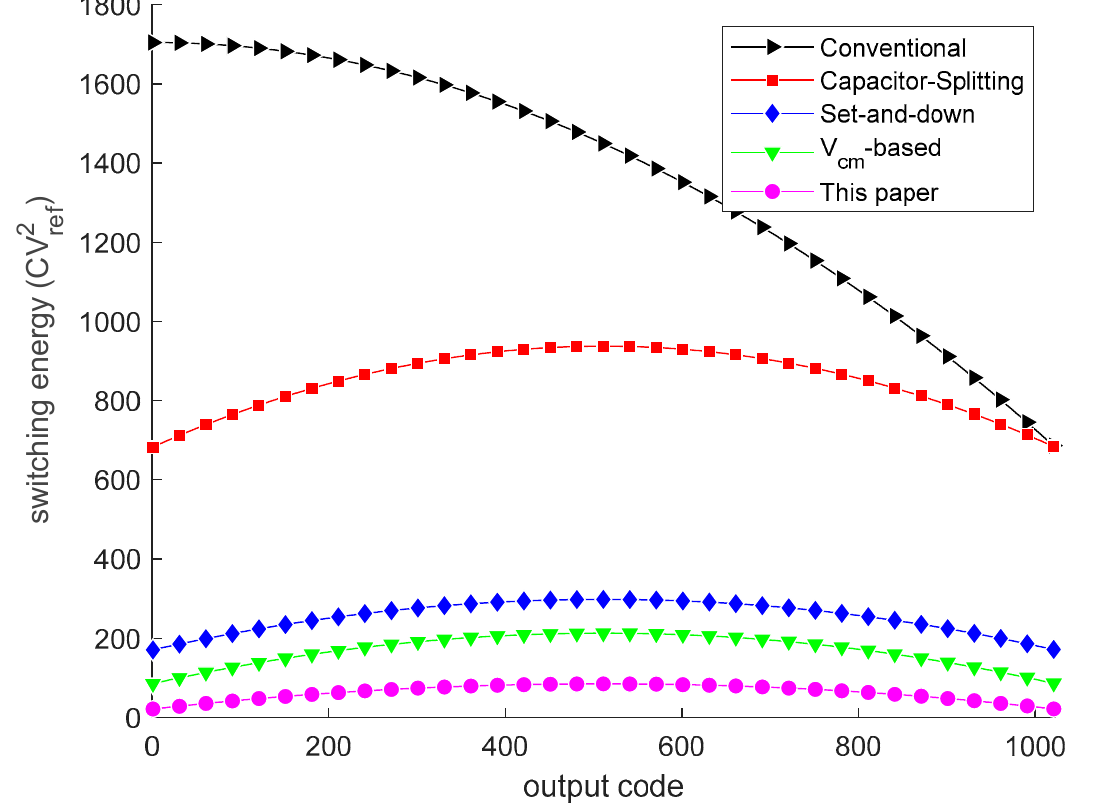
Figure 5. Switching energy against output codes. The black [11], red [8], blue [10], green [9], and magenta curves are switching energy.